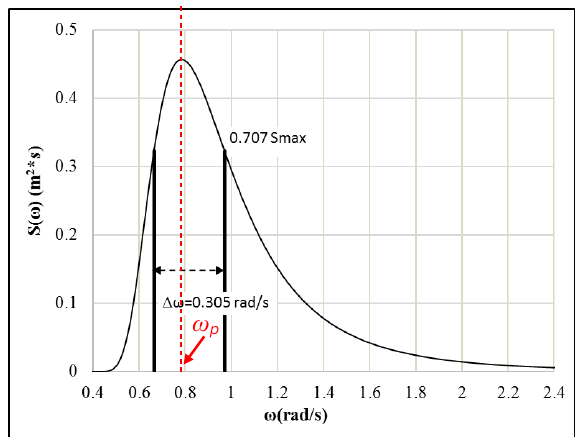
Figure 4. 50% energy concentrated in the bandwidth of 0.305 rad/s (Bretschneider spectrum: H s = 2.0 m, T p = 8.0 s).